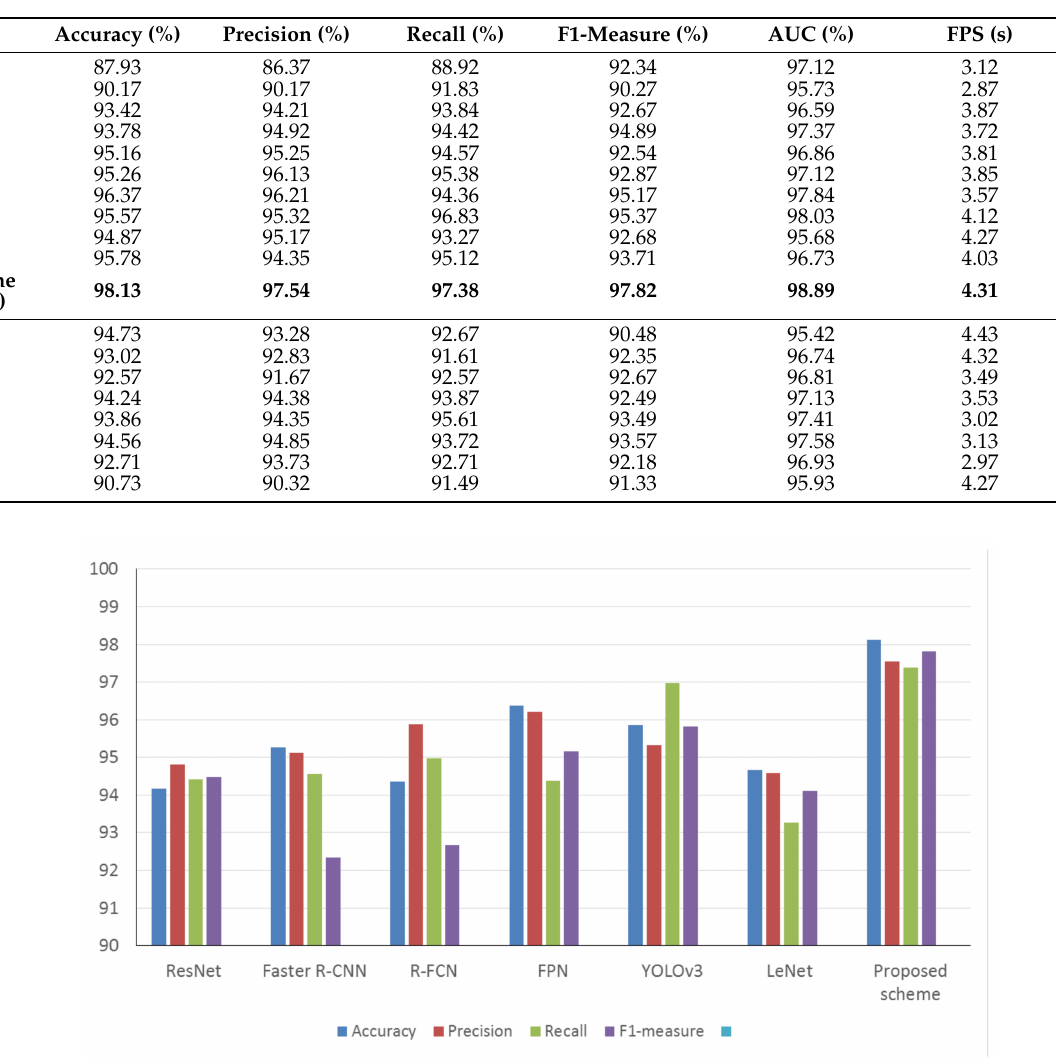
Table 4. Identification results of Buckwheat diseases after region detection.